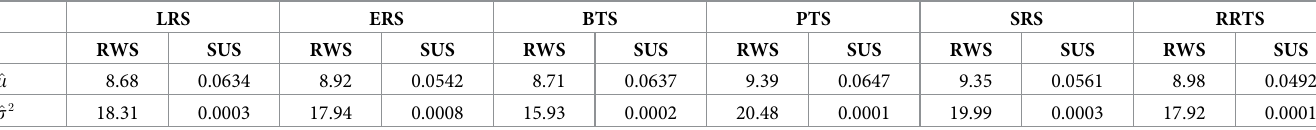
Table 3. Simulated means and variances of the Chi-squared test